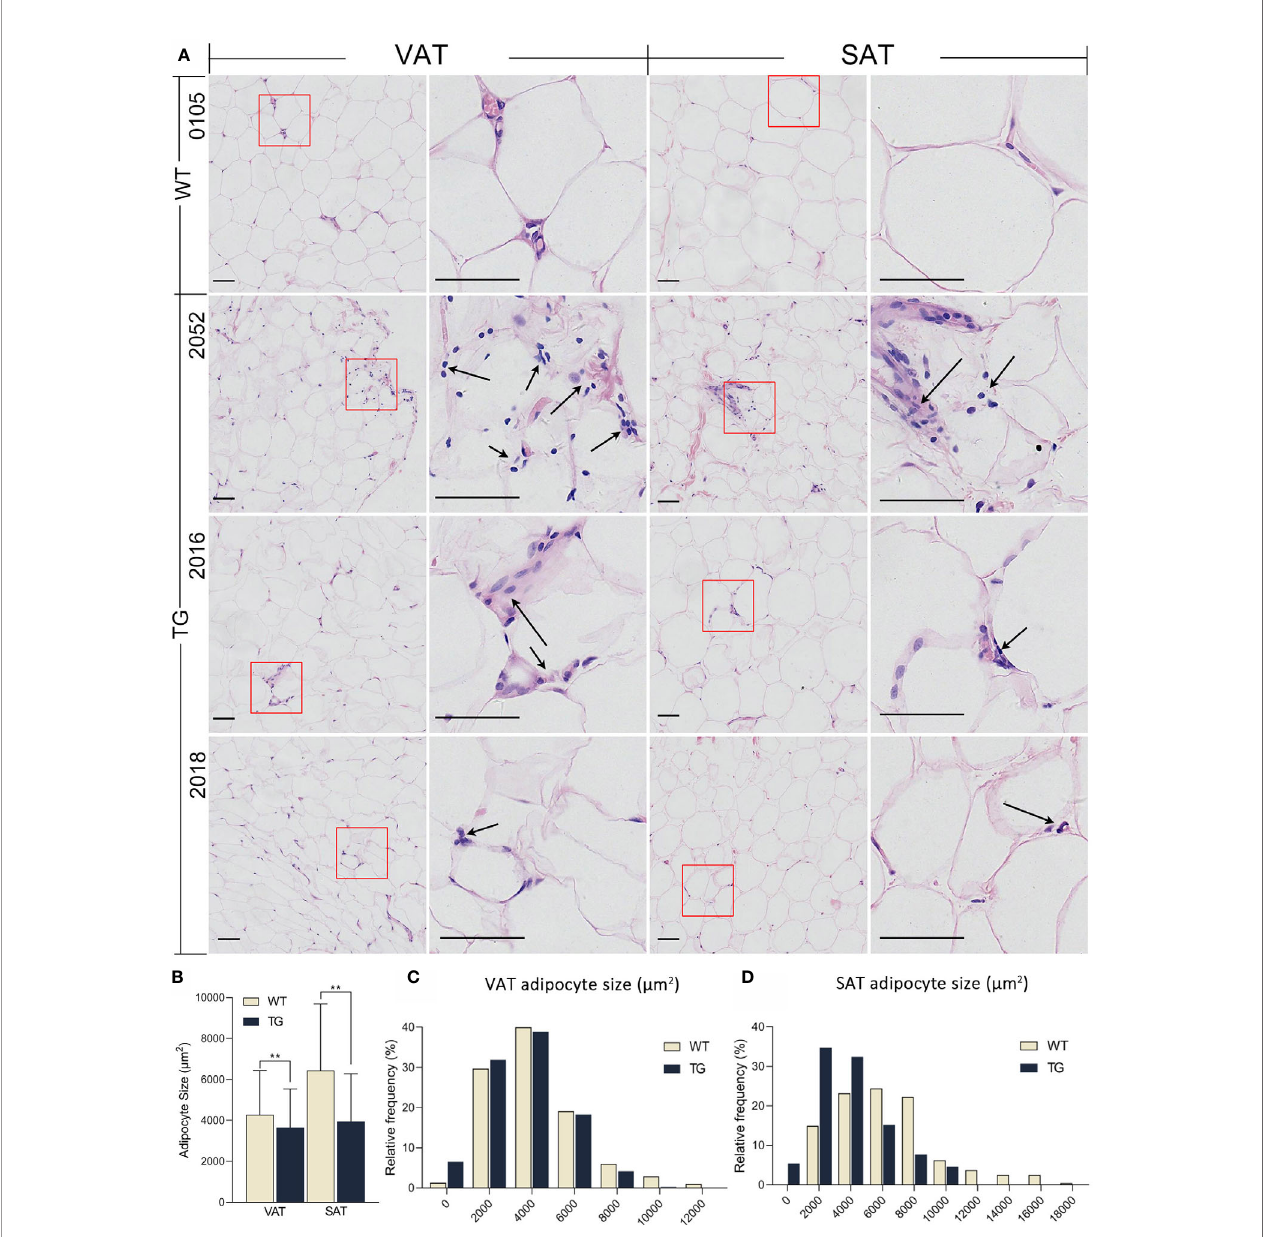
FIGURE 3 | HE staining ofadipose tissues. (A) Visceral adipose tissue (VAT) collected from greater omentumand subcutaneousadipose tissue (SAT) collected from backfat were used for HE staining. Immune cellswere pointed out byblack arrows. Scalebarsare 50 m m. (B) Statistics ofadipocyte size. Three randomly selected views of each samplewere used for statistics, n = 5 per group. (C,D) Frequency distribution of adipocyte size inVAT (C) andSAT (D) from the two groups. **P <